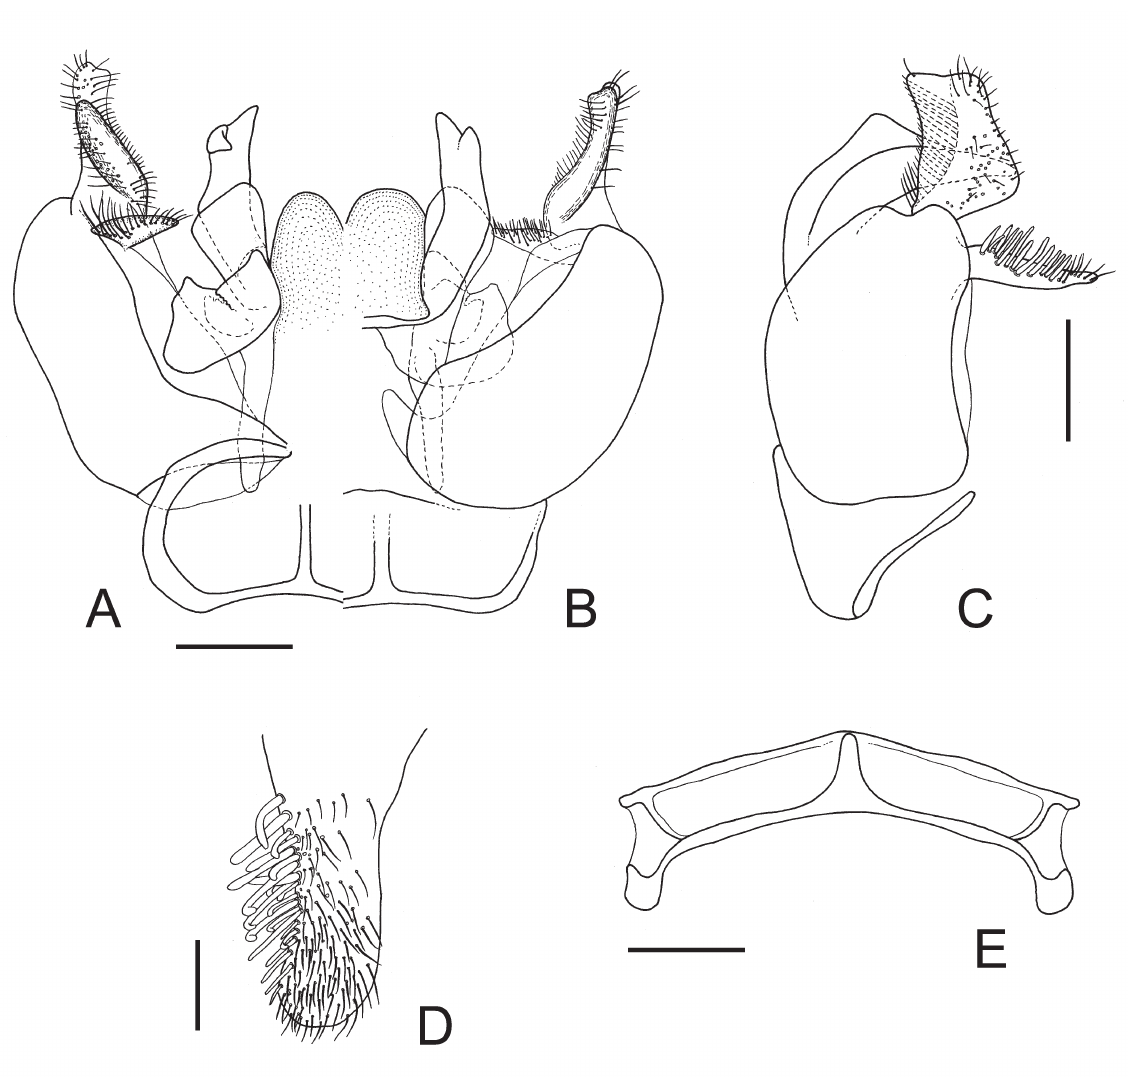
Fig. 18. Lasioglossum ( Dialictus ) alishanense Murao sp. nov., paratype, ♂. A . Genitalia in ventral view. B . Genitalia in dorsal view. C . Genitalia in lateral view. D . Ventral retrorse lobe of genitalia. E . S7–S8. Scale bars: a–c, e = 0.2 mm, d =